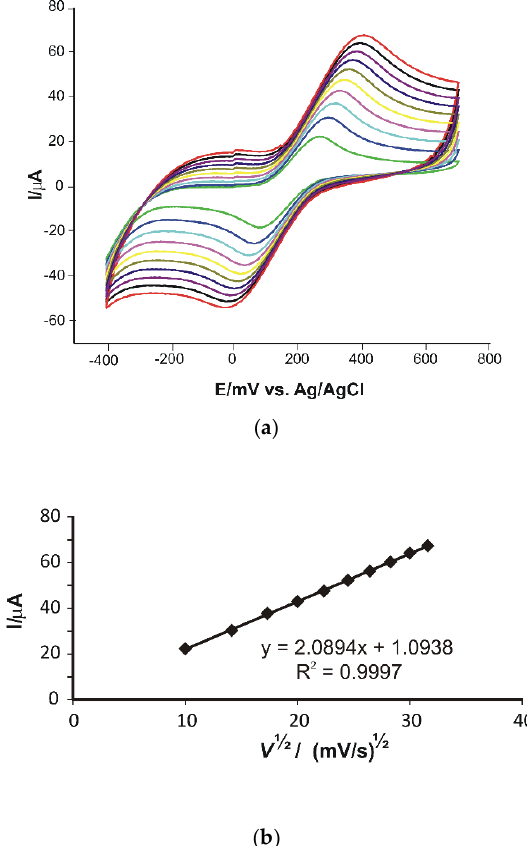
Figure 4. ( a ) Cyclic voltammograms of SPCE-CNT immersed in a 0.001 M K 4 [Fe(CN) 6 ] solution registered with scan rates in the range 0.1–1.0 V · s − 1 . ( b ) The relationship between the anodic peak current values and the square root of the scan